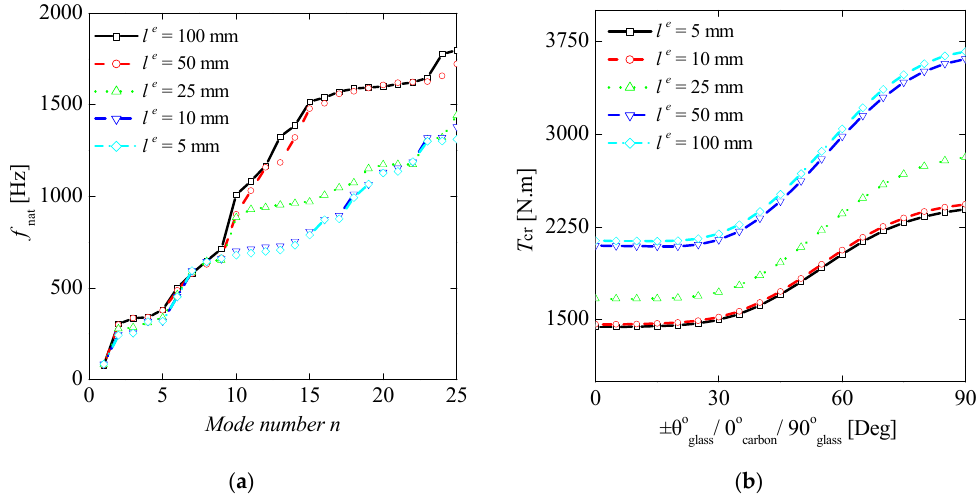
Figure 2. Mesh sensitivity analysis diagram of a hybrid composite driveshaft consisting of 4 layers, stacked up as a [±45° glass /0° carbon /90° glass ] layup, computed for lg = 1730 mm, r = 50.8 mm, and w.thk = 2.032 mm, for ( a ) modal analysis, and ( b ) linear bucking analysis, where the control parameter l e was increased. To detect the appropriate global size, the model was discretized by using the S4R type of element, with the total No of 5536 elements used for l e = 10 mm.